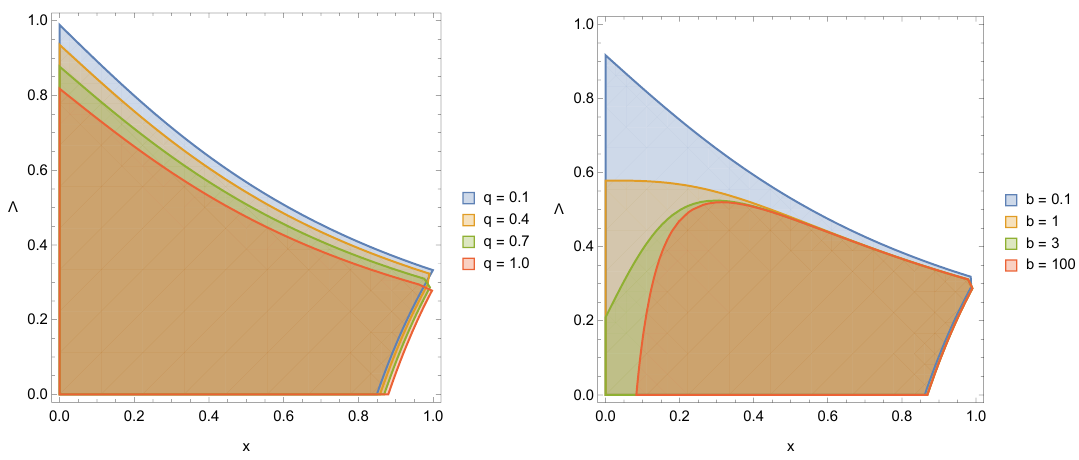
Figure 1 . Regions of positivity for the thermodynamic volume V as a function of x and (cid:3) with p (cid:12)xed cavity radius r c = 3. Shaded regions indicate positivity. Left : varying charge with b = 0 : 1. Right : varying b with q = 0 :